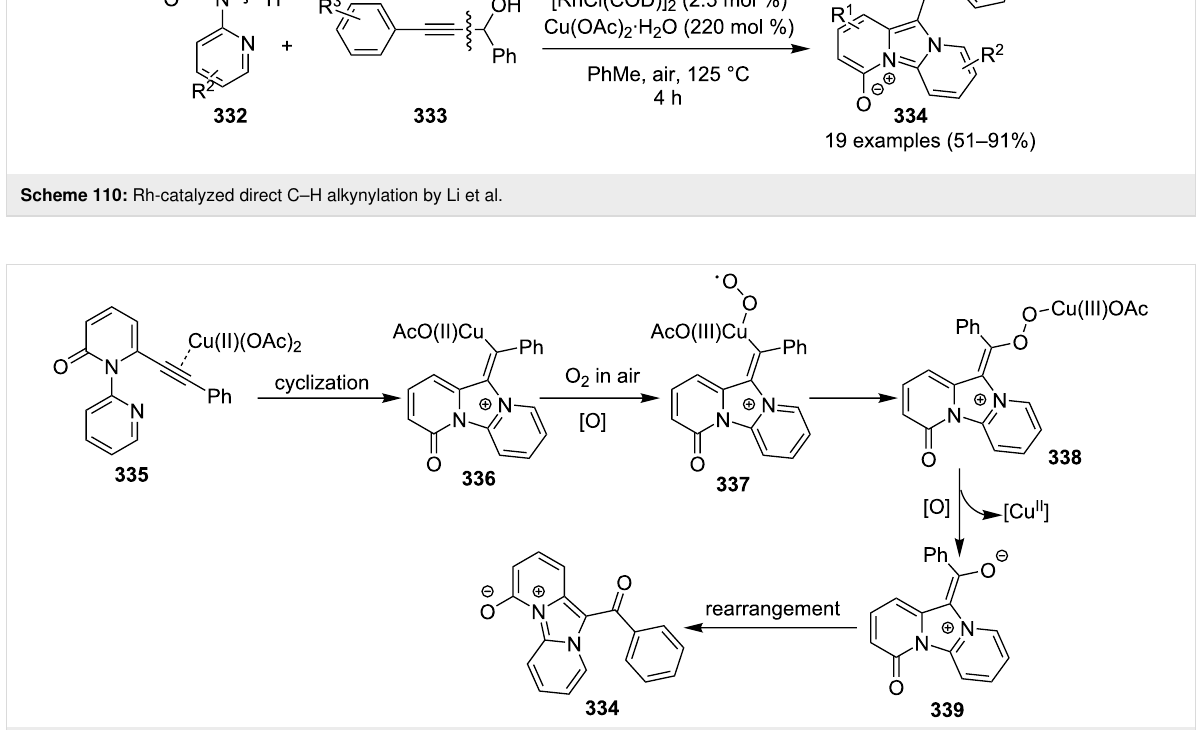
Scheme 111: Suggested radical